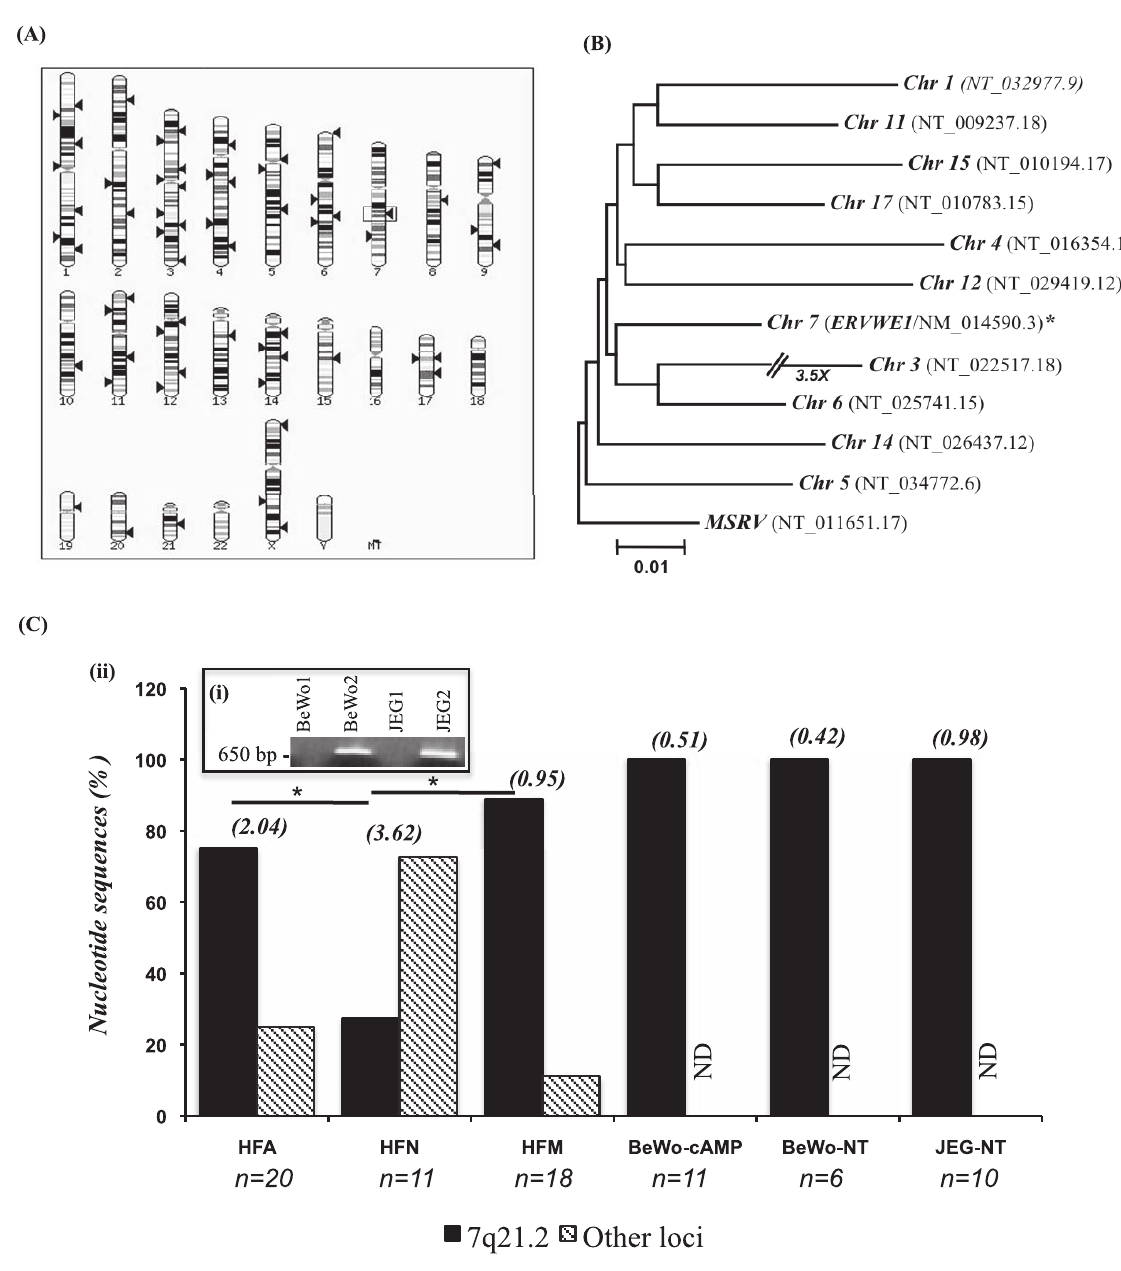
Figure 1. HERV-W env sequence mapping and detection. The human genome contains several endogenous retroviral envelope sequences similar to ERVWE1 . ( A ) Chromosomal loci (arrows) depicting sequences similar to ERVWE1 (accession No. NM_014590). The genomic location of the ERVWE1 locus on chromosome 7 is indicated with a box. ( B ) Phylogenetic analysis of HERV-W env gene at 12 different putative gene loci; the dendrogram was constructed based on DNA sequence by the Neighbor-Joining method using the MEGA4 program. The tree is rooted to the MSRV prototype env sequence, which was used as an out-group gene sequence. ( C ) Amplification and cloning of the 650 bp region of HERV-W env gene: ( i ) ethidium bromide-stained agarose gel showing HERV-W env gene amplicons JEG and BeWo cell lines, ( ii ) frequency of HERV-W env cDNA sequences cloned from human fetal astrocytes (HFA), neurons (HFN), microglia (HFM) and immortalized cell lines. In primary cells, HERV-W env sequences were derived from the 7q21.2 (ERVWE1) locus as well as other loci, while all HERV-W env sequences from immortalized cell lines appeared to be encoded by 7q21.2. The values in parenthesis indicate percent diversity among clones for each patient relative to ERVWE1. (ND=none detected). doi:10.1371/journal.pone.0019176.g001 ( Figure S2 ). Among the non-ERVWE1-derived sequences, sequence variability (0.02% among 14 cloned sequences) although chromosomes 14 and 15 ( Figure 5B ) were the most active sites sequence diversity within the clinical samples ranged from 4.09 of HERV-W env transcription while the X chromosome was the to 5.35% depending on the individual sample ( Figure 5Aii ). least active. These observations emphasized the multiplicity of Sequence alignments and phylogenetic analyses of the HERV-W env sequences showed that brain-derived sequences grouped with encoding loci for potential HERV-W env alleles, which depended on age and health status of the subject. multiple HERV-W env sequences located on different chromosomes